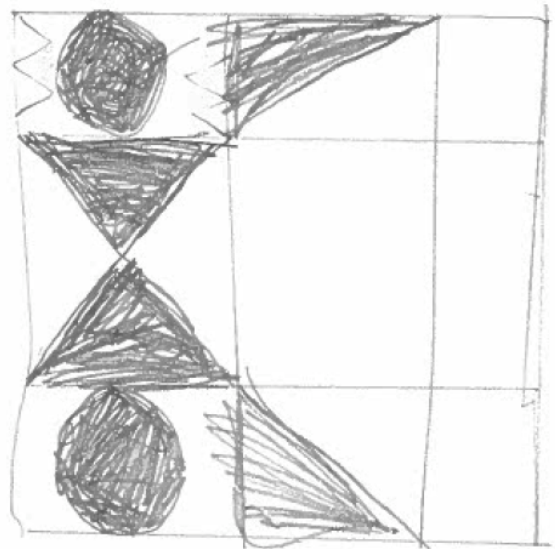
Figure 3. Group 2’s created